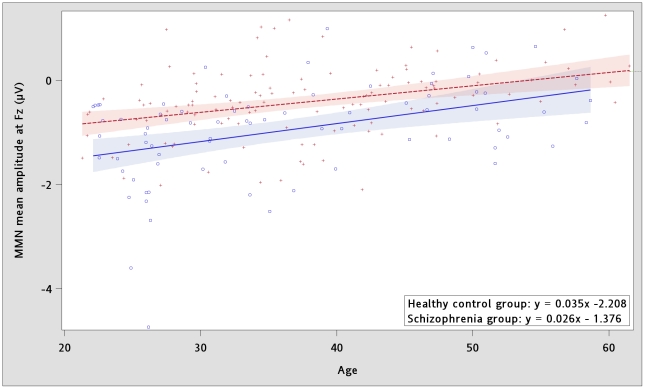
Effects of age on mismatch negativity.Mean mismatch negativity amplitude (135–205 msec) at electrode Fz reduces with aging. The reduction rate were not significantly different between healthy control group (open circles and solid regression line) and schizophrenia group (crosses and dashed regression line).